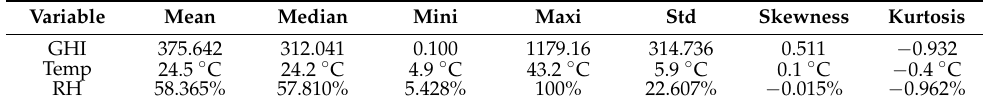
Table 3. Summary statistics for GHI, temperature and